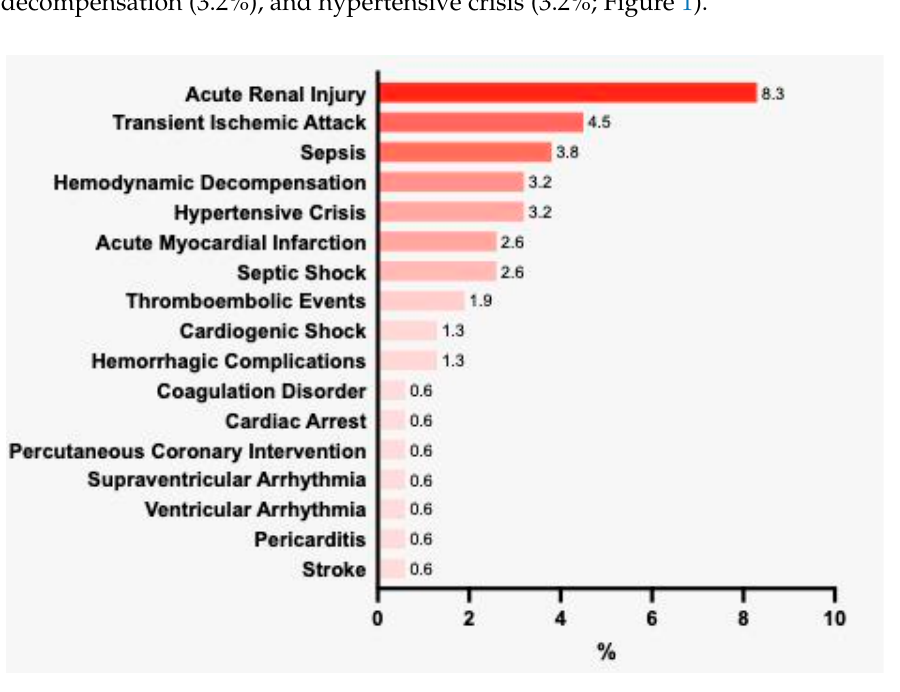
Figure 1. Main complications occurring during hospitalization (%).